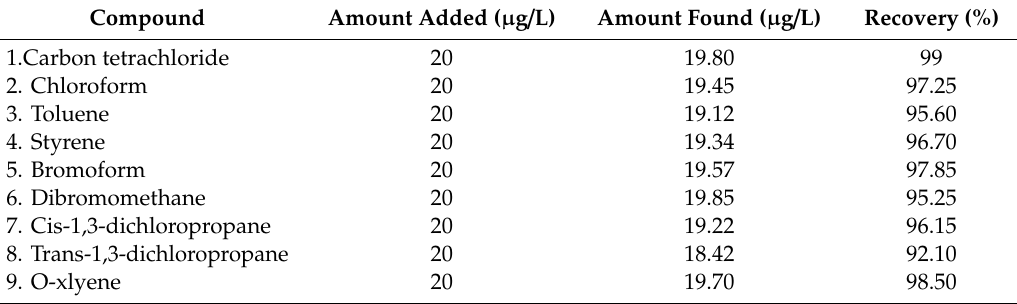
Table 1. Compounds, amount added, amount found, and % of recovery tests of synthetic mixtures of organic compounds from water